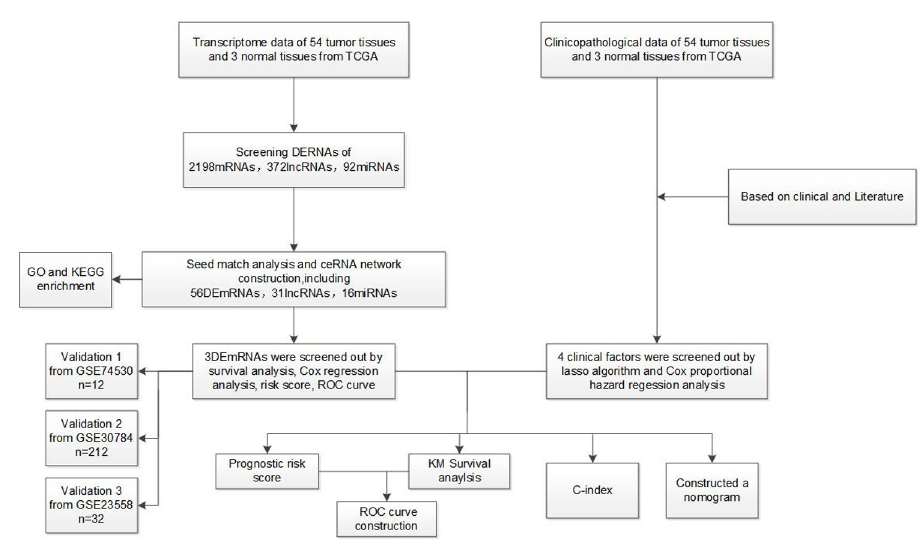
Fig 9. Flow chart of the bioinformatics method.